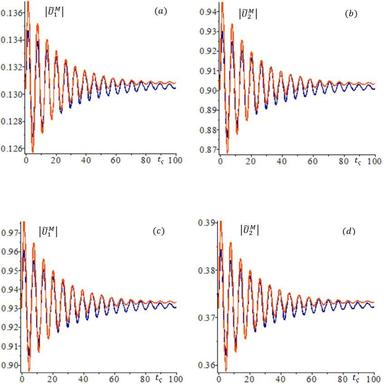
Dimensionless macro-displacement component U˜ M α (xβ /L = 5/11,tς ) induced by bˆα (xβ ), with α = 1, 2 and β = 1, 2, are expressed in terms of dimensionless time tς : (a) U˜ M 1 (x1/L = 5/11,tς ); (b) U˜ M 2 (x1/L = 5/11,tς ); (c) U˜ M 1 (x2/L = 5/11,tς ); (d) U˜ M 2 (x2/L = 5/11,tς ). The red curves are given for the dimensionless relaxation time τ 1 ς = τ 2 ς = 20 and the blue ones for τ 1 ς = τ 2 ς = 10 with rρ = rE = 10, ν˜1 = ν˜2 = 0.2, η = 1 and γ = 1. (For interpretation of the references to colou